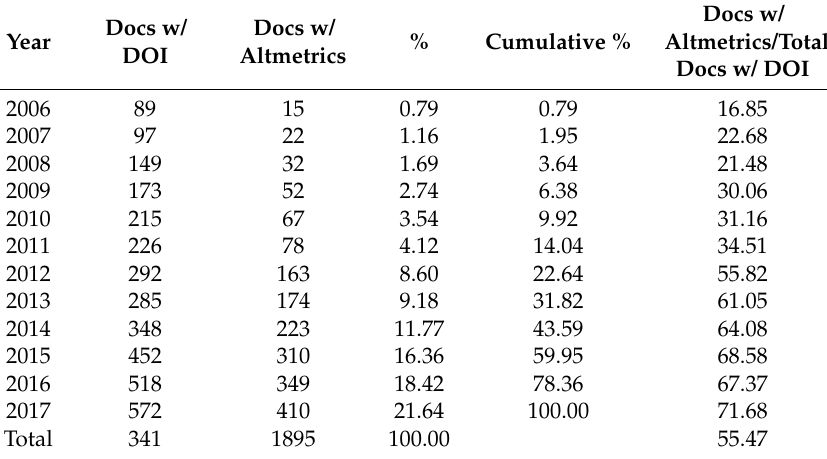
Table 4. Number of documents mentioned in social